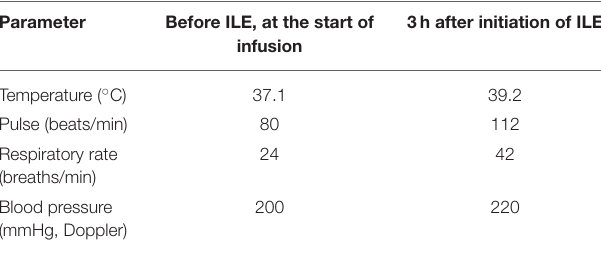
TABLE 2 | Vital parameter trends noted on the Infusion Monitoring